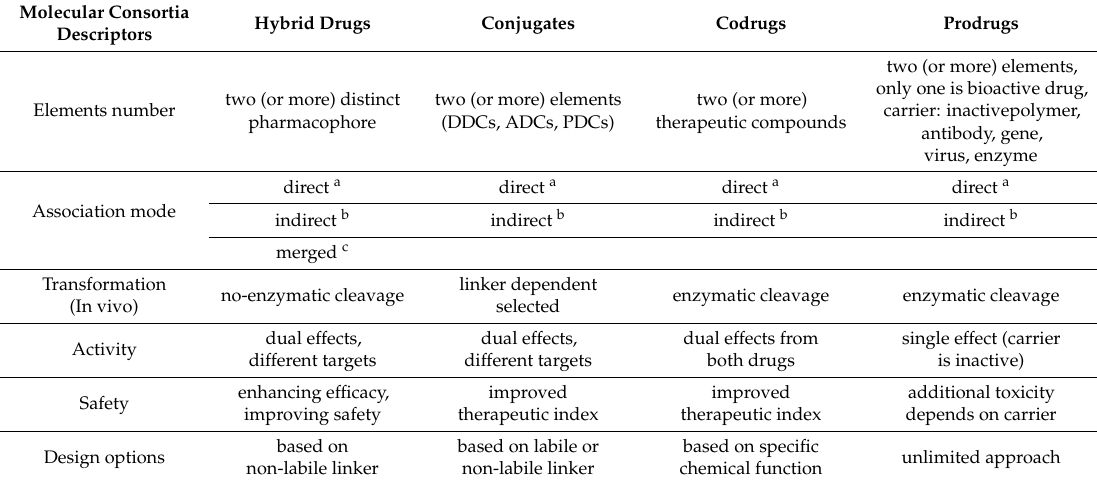
Table 3. Comparative characteristics the main type of hybridized